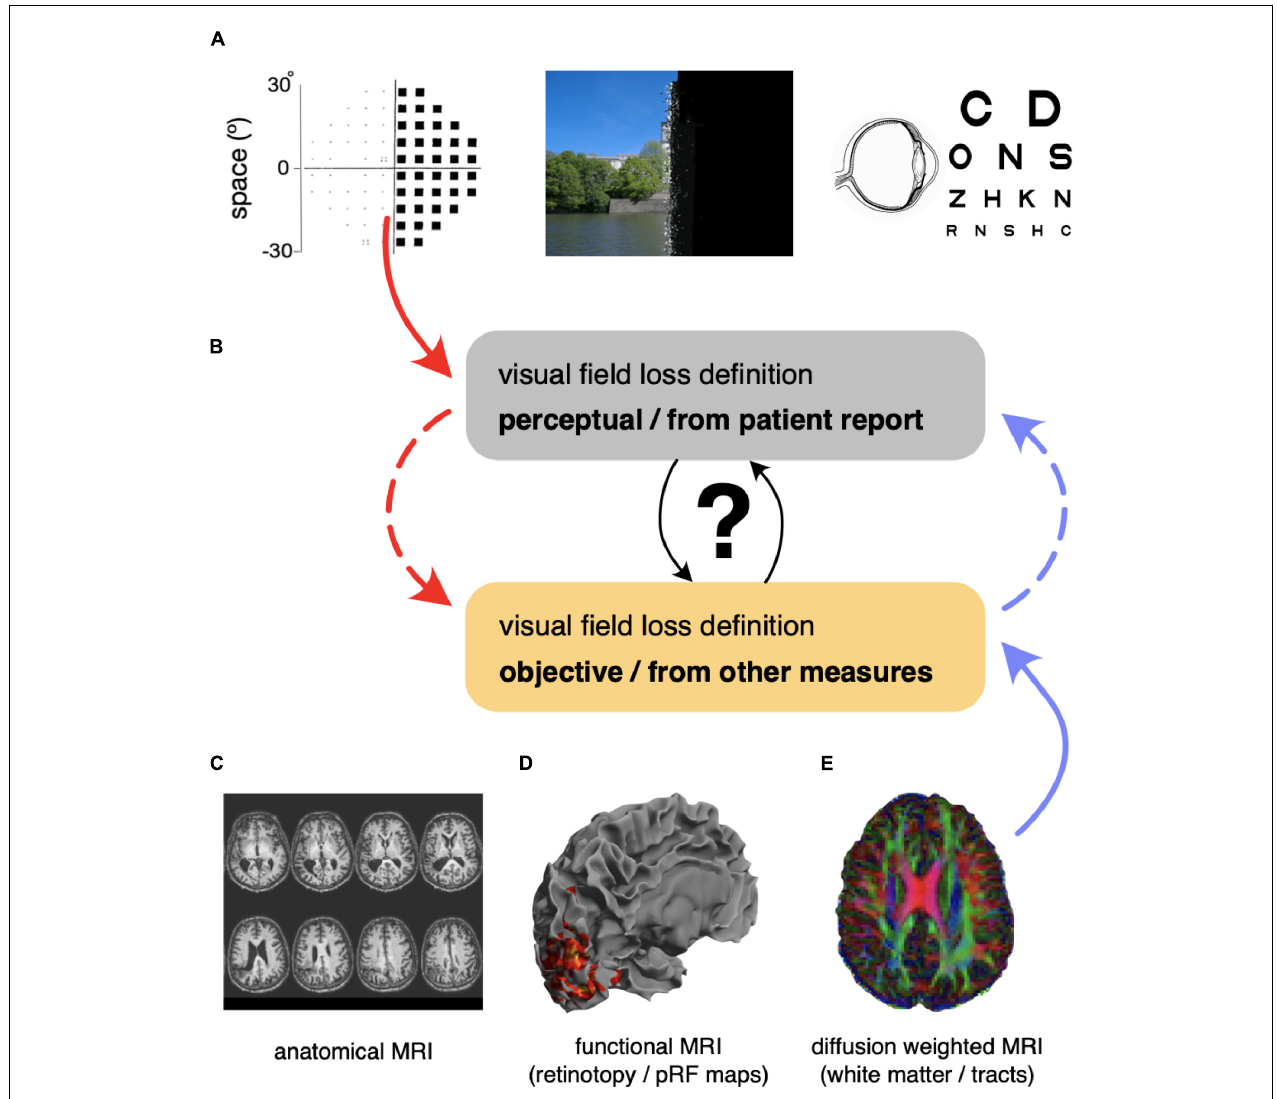
FIGURE 1 | Overview of visual function measurements and how they can be combined. (A) Perimetry and informal reports of visual experience give reproducible assessments of patients’ perceptions, but they can be subjective. All participants had a full optometric and ocular health assessment. (B) Mapping of standard clinical measurements of visual function to less commonly used assessments of brain function, which provide a complementary picture of visual function loss. (C) Example of anatomical lesions as seen with T1-weighted magnetic resonance imaging. (D) Functional MRI provides information about visually responsive regions in ipsi- and contra-lesional cortex. (E) Diffusion weighted imaging can provide information about the intactness of white-matter pathways underpinning visual function (e.g., optic radiation, OR, vertical occipital fasciculus,